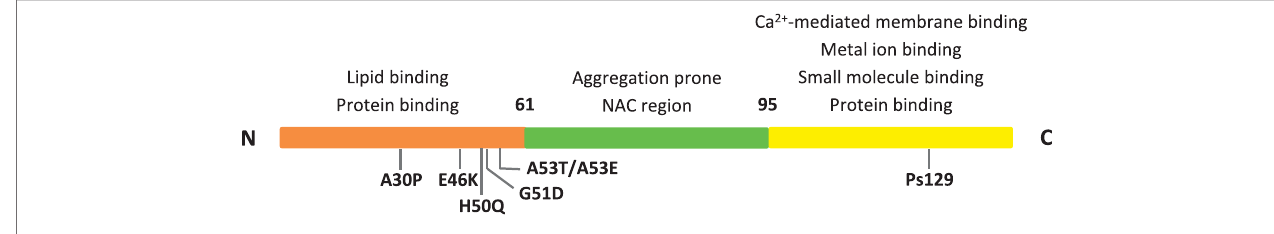
FIGURE 1 | The three α Syn regions are represented in different colors. Their properties, along with the main PD mutations and interacting sites are